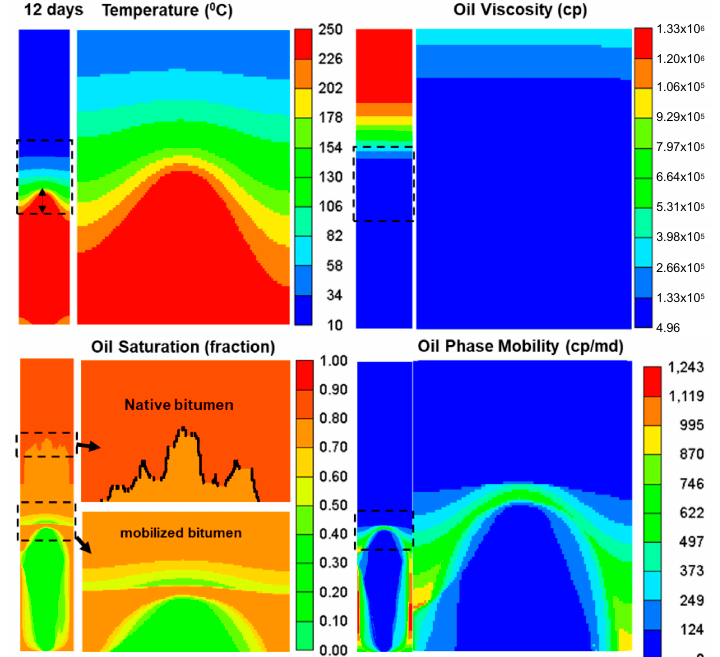
Figure 19. 2D images of the temperature, oil viscosity, oil saturation and oil phase mobility distributions in the VE model after 5 days of steam injection. Zoomed in views are displayed of the region enclosed by the dashed black line square. Energies 2020 , 13 , x